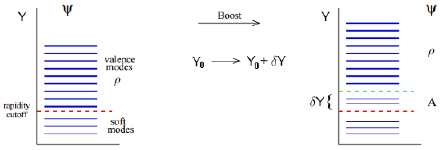
Figure 1 . The LCWFs before and after boost. Here (cid:26) stands for the colour charge density of the valence modes, and A for the soft gluon